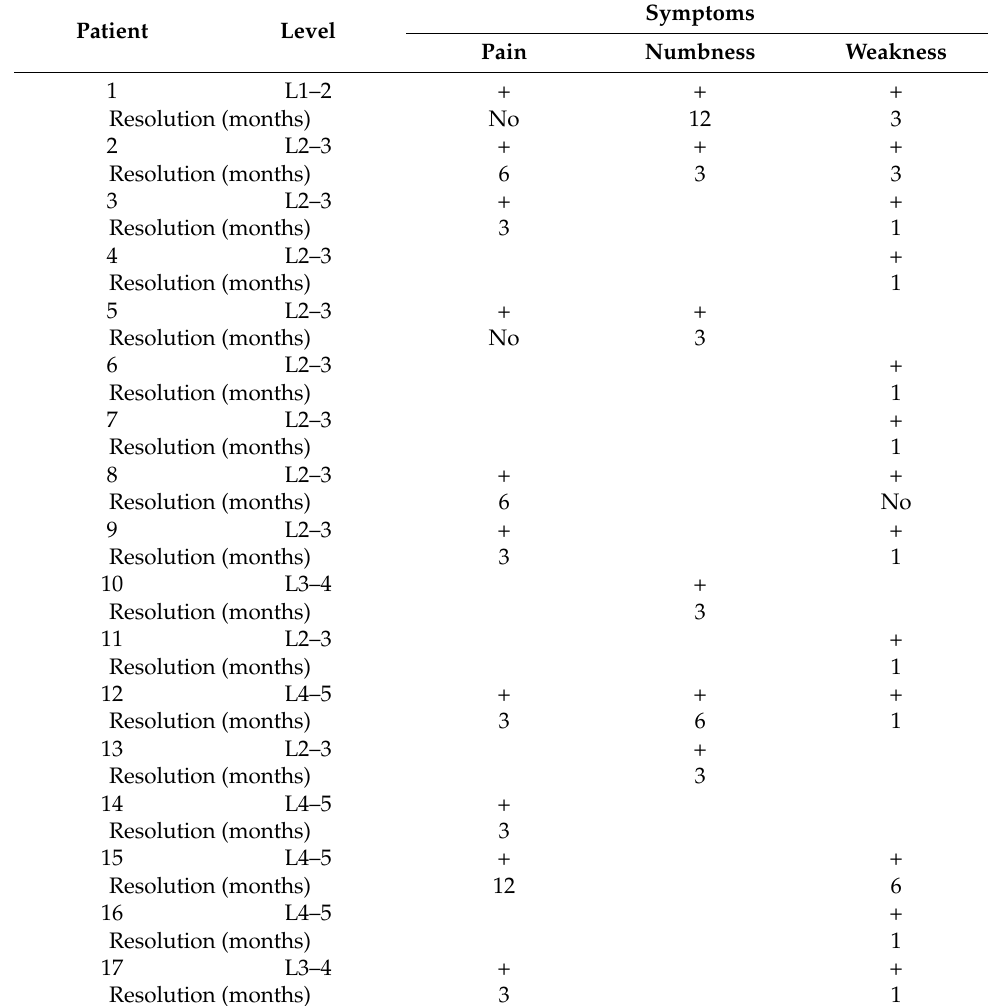
Table 4. Thigh symptom group ( n =